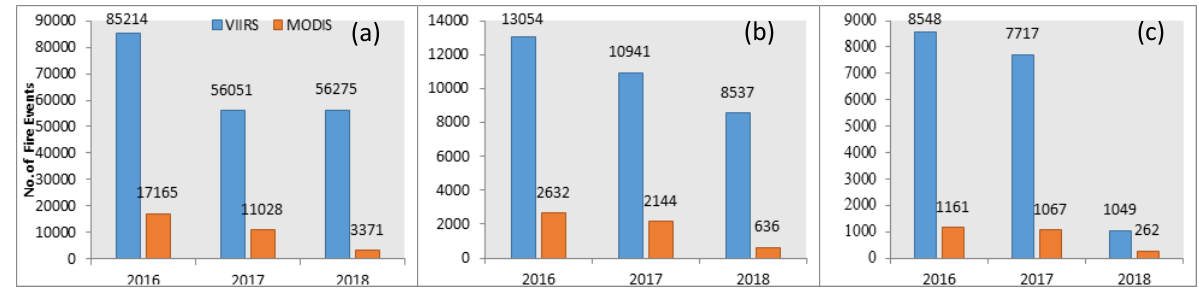
Figure 4. Comparison of number of active fire locations detected by MODIS and VIIRS sensors during 2018, 2017 and 2016 for (a) Punjab, (b) Haryana, and (c) UP.